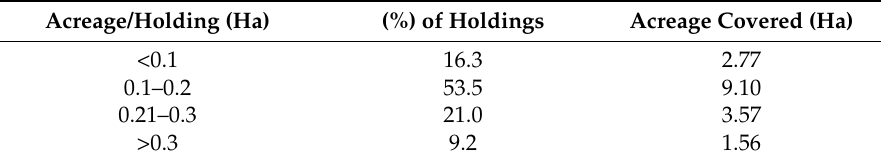
Table 2. Structural characteristics of the sample.